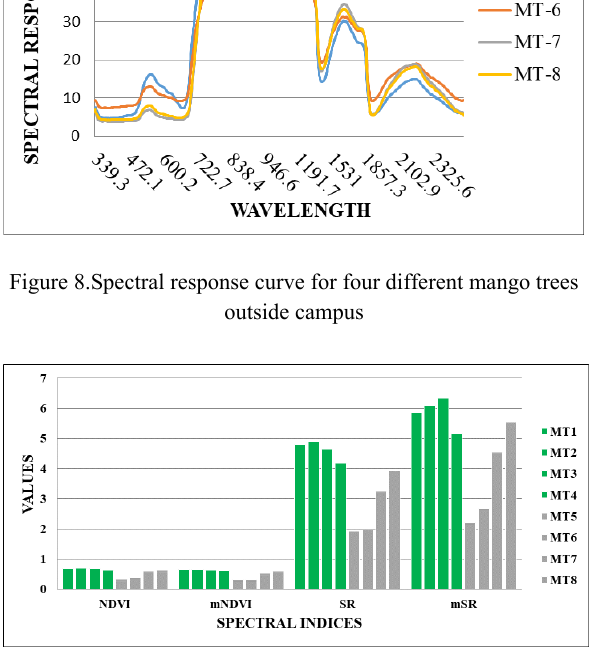
Figure 9.Comparison of different spectral indices for